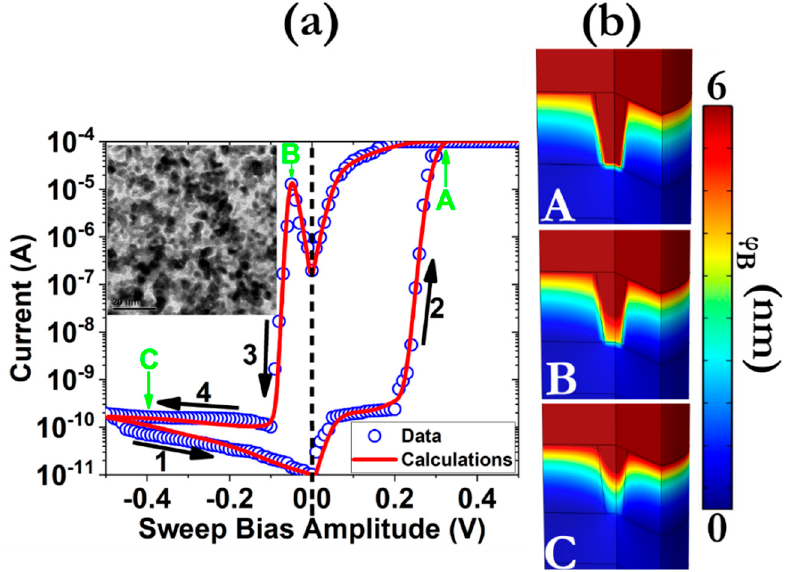
Figure 1. ( a ) Measured and calculated I–V hysteresis patterns during the application of 0.5 V external bias, under the application of a compliance current (I CC ) limit of 100 µ A. The inset picture depicts a TEM plan view image of the dense layer of Pt of nanoparticles (NPs). The scale bar in the TEM figure corresponds to 20 nm. The arrows in the graphs indicate the switching direction, while the sweep rate was 10 mVs − 1 . Similar switching patterns were captured by beginning the sweeps from 0 V to |Vmax| (not shown here). ( b ) 3D calculated maps of the conducting filament (CF) effective diameter distribution for states A (+0.3 V), B ( − 0.05 V) and C ( − 0.4 V).